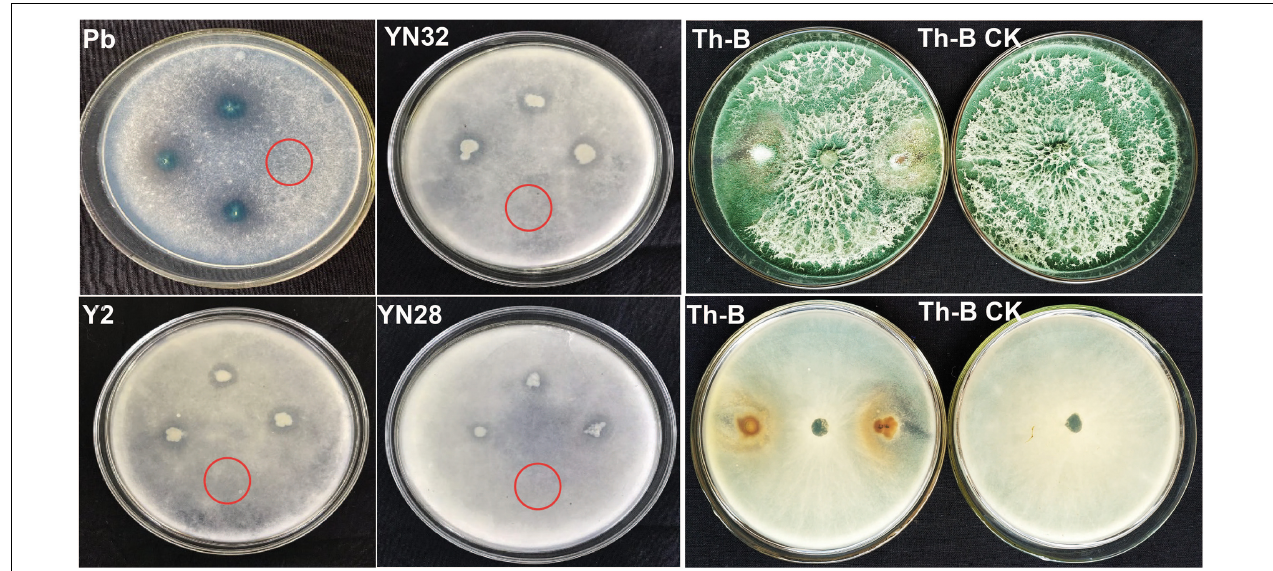
FIGURE 1 | Lab screening of antagonist against fungal pathogen. Biocontrol agents with different inhibitory effects against Rhizopus oryzae . Pseudomonas sp. (Pb) , B. amyloliquefaciens YN201732 (YN32), B. amyloliquefaciens B9601-Y2 (Y2), and B. amyloliquefaciens YN201728 (YN28) were tested in vitro . Trichoderma (Th-B) displaying antifungal activity against fungal pathogen, which occupied all the space in the plate. Inverted section of Th-B showing that the candidate strain antagonizes the pathogen. The red circle indicates that the control treatments showed no inhibition.